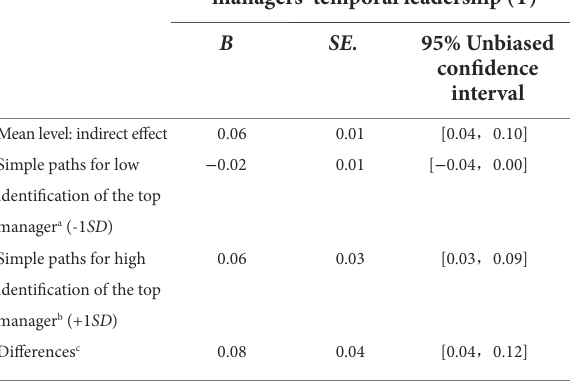
TABLE 4 Results of the moderated path analysis.